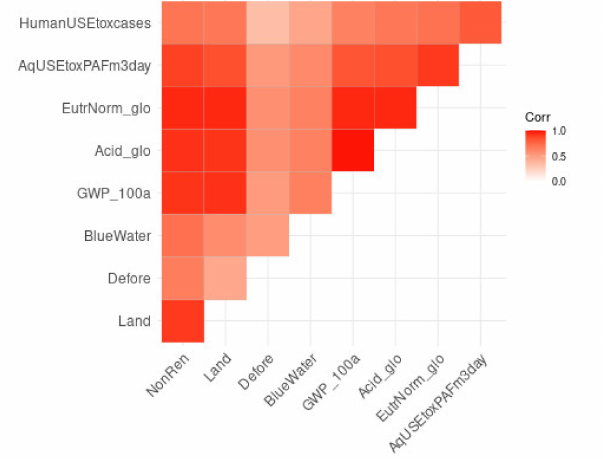
Figure A2. Correlation coefficients environmental impact indicators (all shown coefficients have p -values <